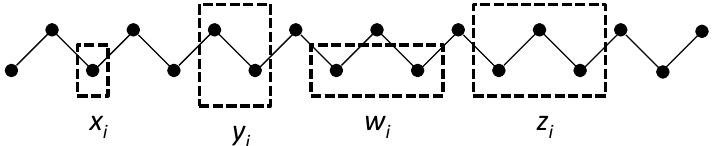
Figure 2. The 1-D single zigzag chain is created by arranging two staggered sets of M units each. The configuration variables shown are x i (single units), y i (nearest-neighbors), w i (next-nearest-neighbors), and z i